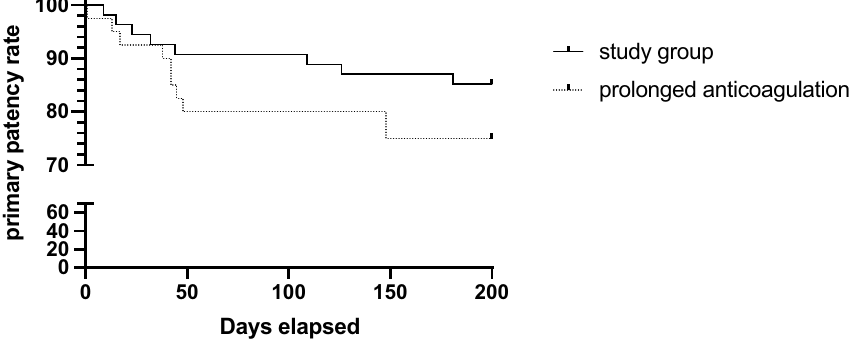
Figure 1. primary patency rate. Kaplan–Meier curve compares the primary patency rate between patients with unfractionated heparin for three days (study group) and patients with prolonged anticoagulation.